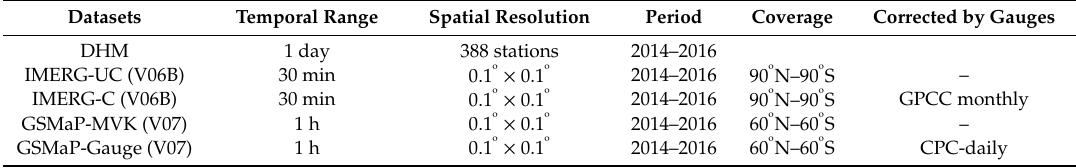
Table 1. Details of the datasets used in this